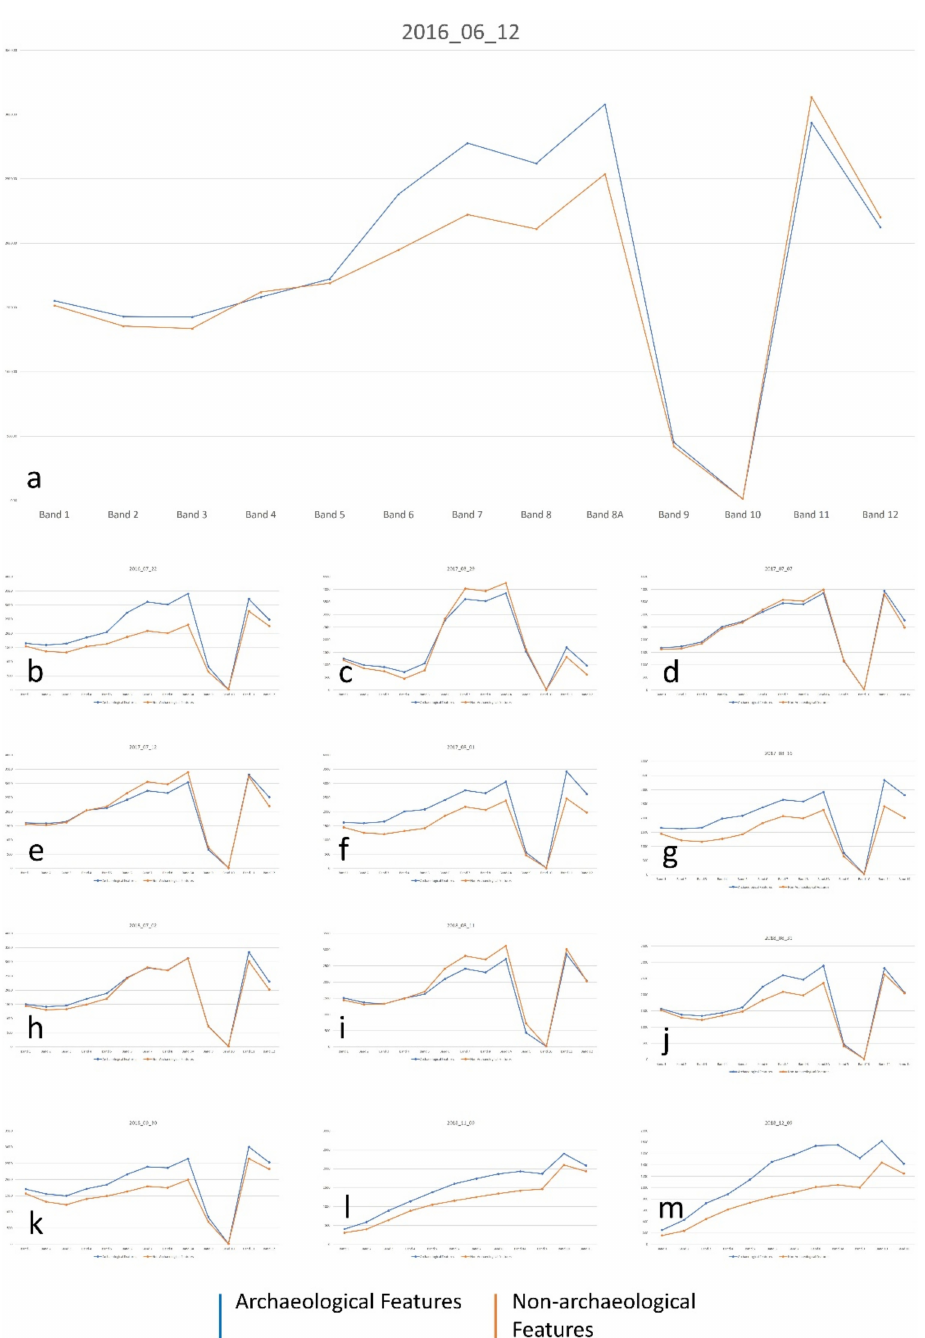
Figure 5. Spectral Signature (average) of individual Sentinel-2 bands based on identified ROIs: ( a ) 2016-06-12; ( b ) 2016-07-22; ( c ) 2017-03-29; ( d ) 2017-07-07; ( e ) 2017-07-12; ( f ) 2017-08-01; ( g ) 2017-08-16; ( h ) 2018-07-02; ( i ) 2018-08-11; ( j ) 2018-08-31; ( k ) 2018-09-30; ( l ) 2018-09-11; ( m ) 2018-12-09. The same process was subsequently applied to the di ff erent indices produced from the band maths operation (Table 2) (Figure